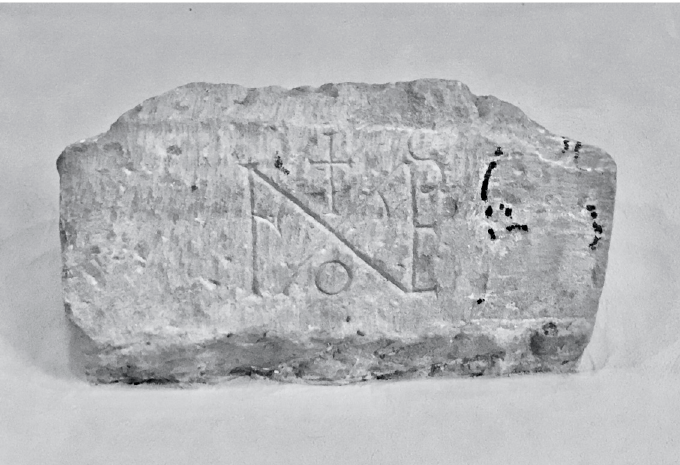
Figure 10. Impost block with Maximian’s monogram, Museo Arcivescovile, Ravenna (photo: author).